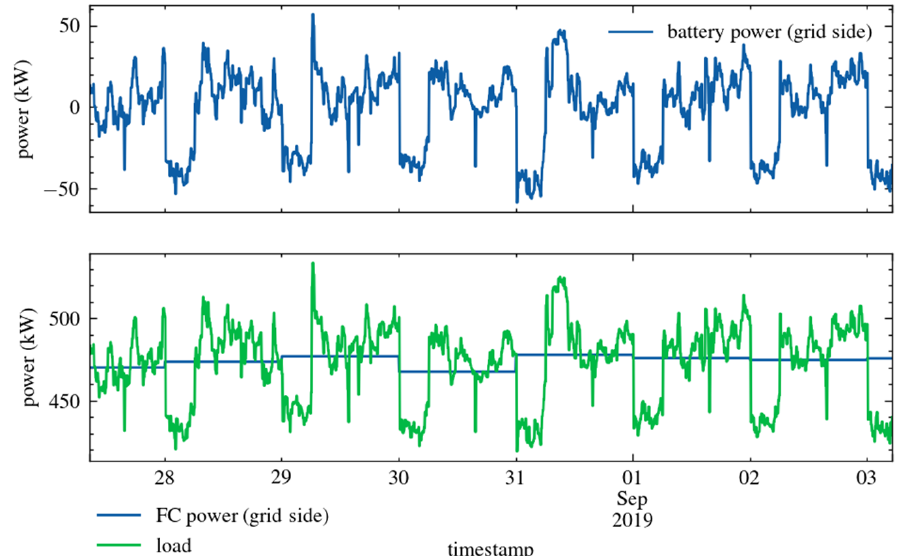
Figure 10. Grid-side powers in Scenario 2.